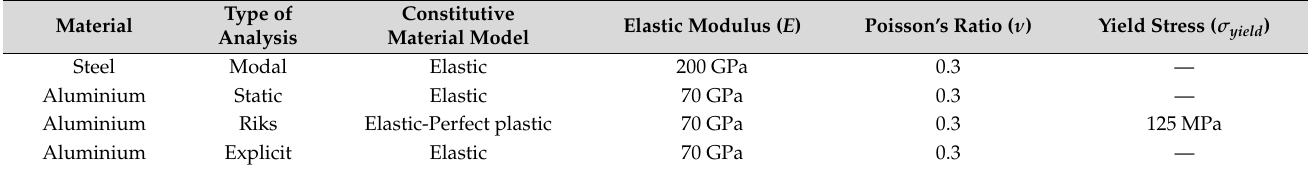
Table 2. Material properties used for the FE